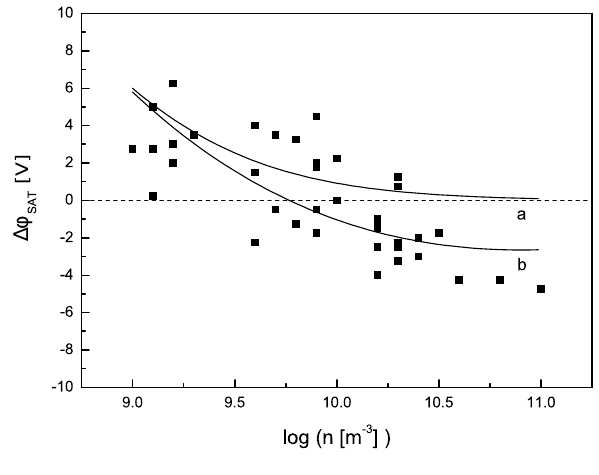
Fig. 7. The change in the satellite potential caused by a quasi- neutral plasma emission as a function of the ambient plasma